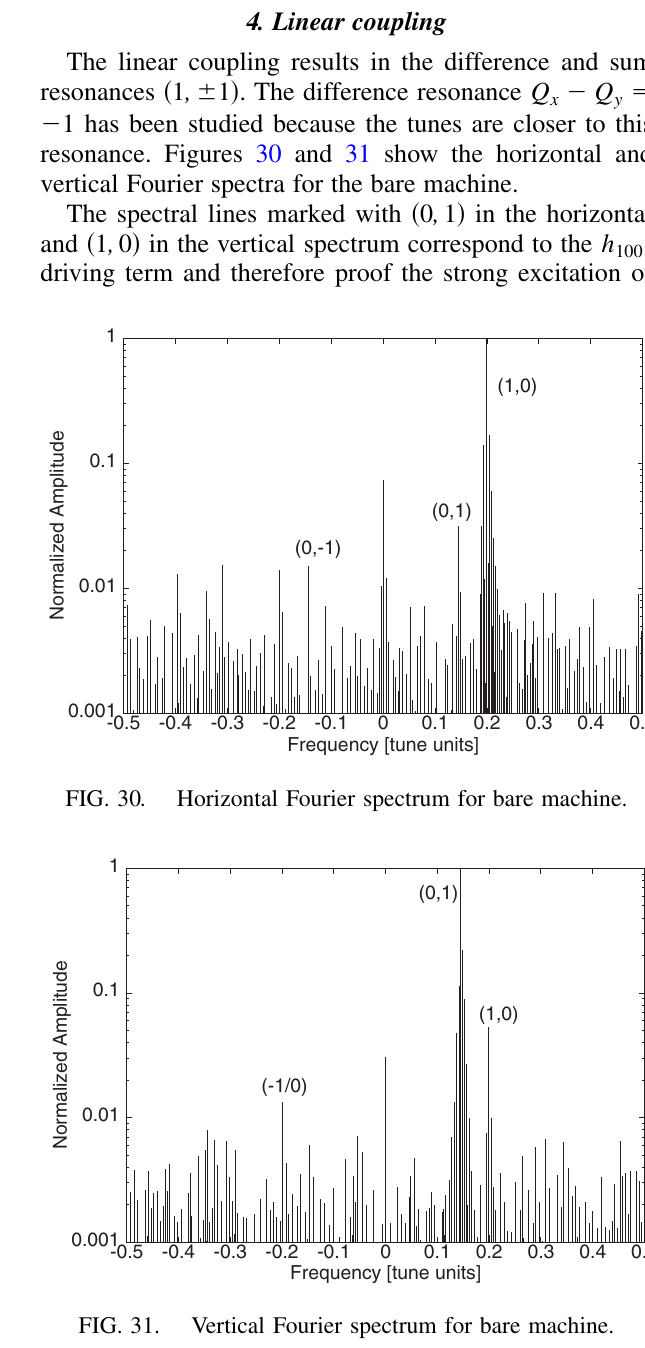
FIG. 29. Vertical Fourier spectrum with compensation.